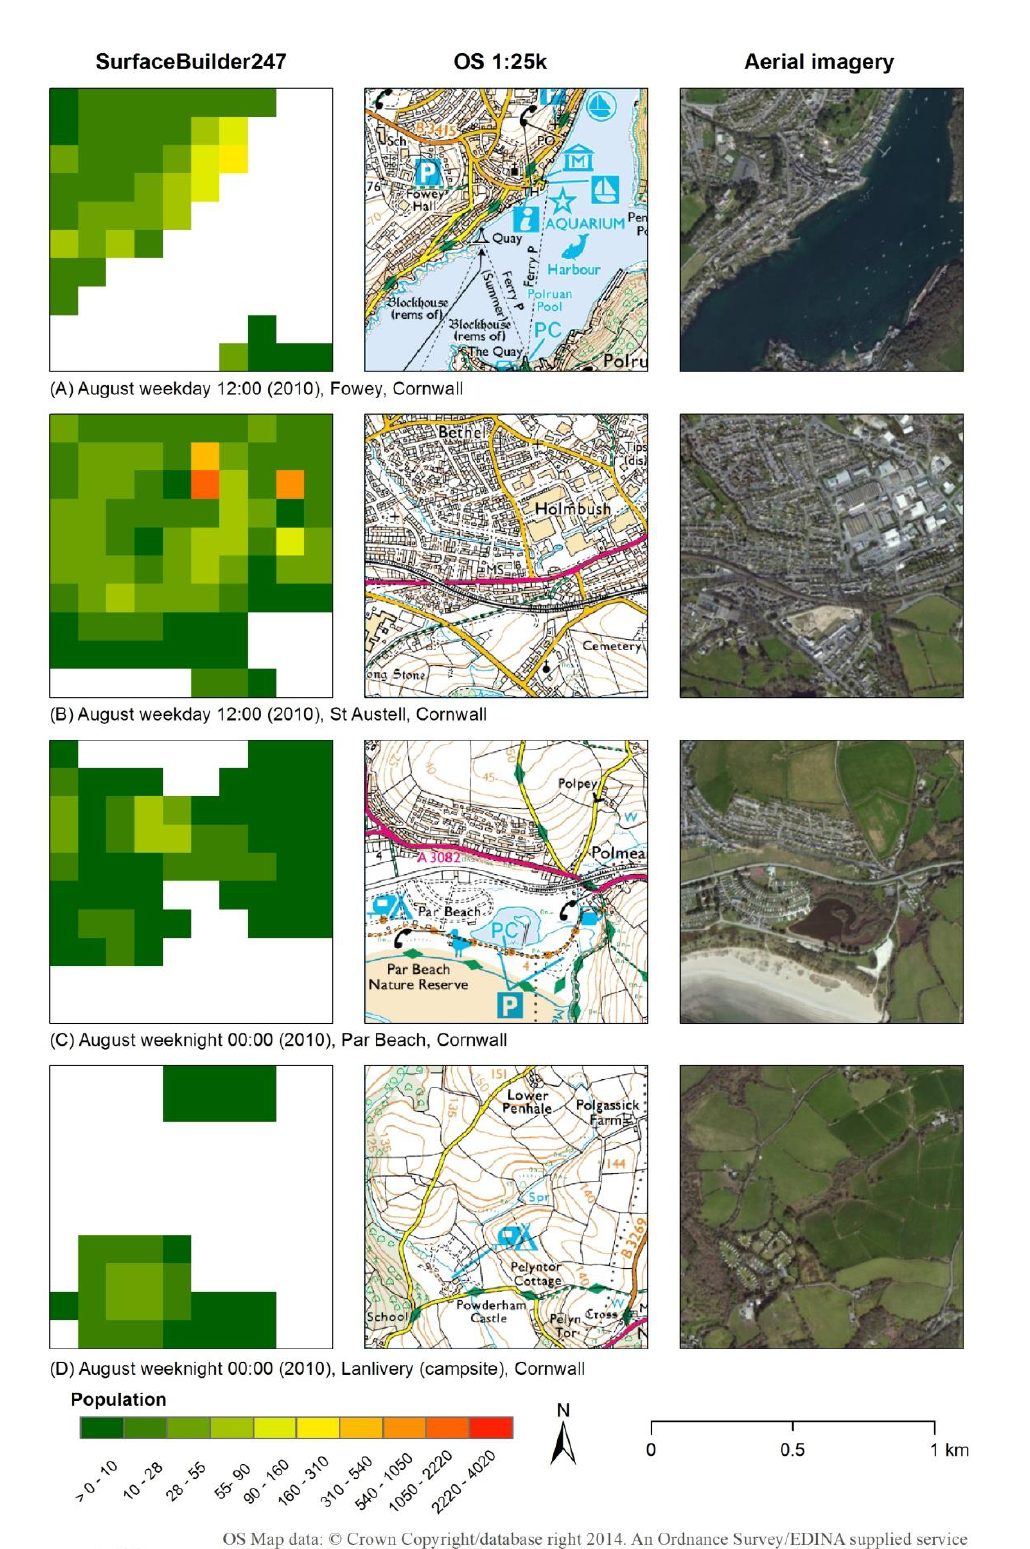
Figure 9. A detailed comparison of SurfaceBuilder247 (100 metre resolution) results within the St Austell study area with 1:25,000 scale OS background mapping and aerial imagery for selected 1 km national grid squares. ( A , B ) August weekday “daytime” population. ( C , D ) August weekday “night-time”